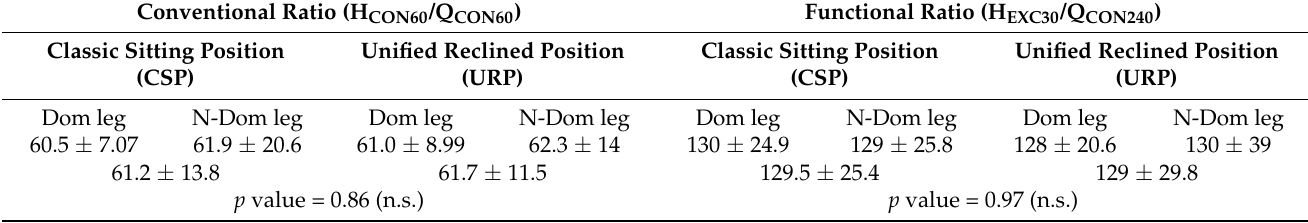
Table 3. Conventional (H CON60 /Q CON60 ) and functional (H EXC30 /Q CON240 ) ratios in CSP and URP. Data for each group (n = 20) are shown as mean and standard deviation (mean ±